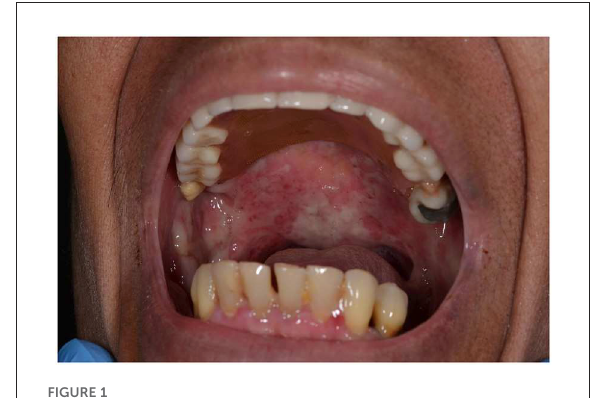
FIGURE1 Blisters and erosions in the oral cavity of our